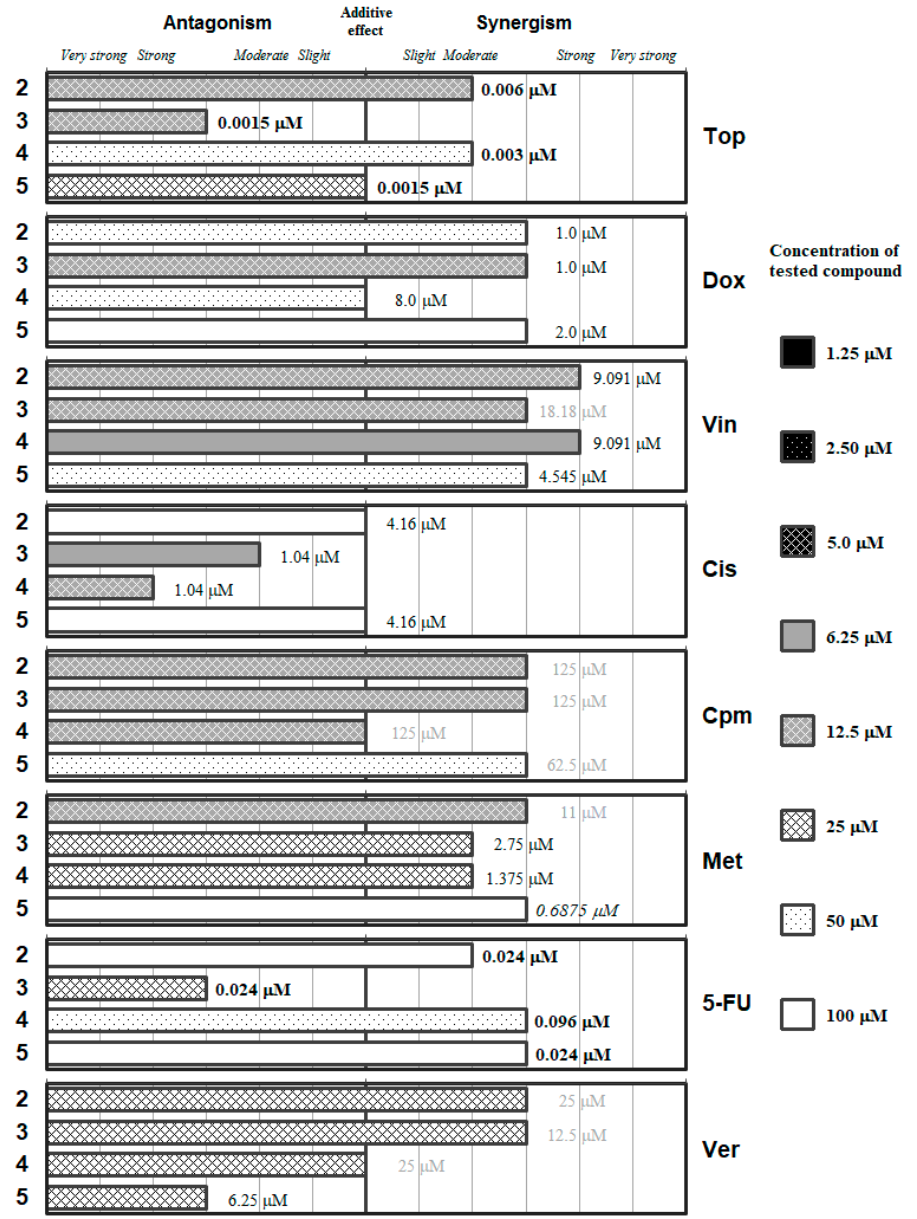
Figure 3. Interactions of the symmetric diselenodiesters ( 2 – 5 ) with a panel of anticancer drugs ( Top , Dox , Vin , Cis , Cpm , Met and 5- FU ) or an efflux pump inhibitor ( Ver ). Concentration of the tested compound is given according the legend; concentration of the anticancer drug is given in numbers inside the graph (in bold: below 0.1 μ M, in italics between 0.1 μ M and 1 μ M, and in grey above 10 μ M).